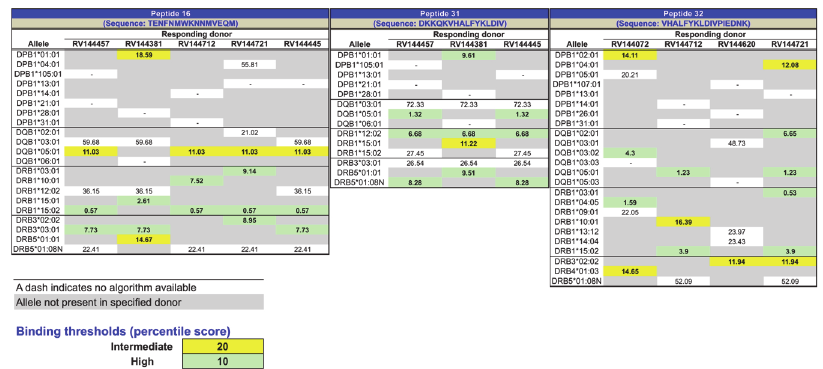
Table 1. Comparison between bAb responses and CD4+ T helper responses to C1 or V2 (p31 or p32 as indicated) respectively within the same individual. CD4 T helper C1 bAb C1 CD4 T helper V2 bAb V2 RV144072 X (p32) RV144621 RV144457 X X (p31) X (p32) X X (p31) X X X (p32) X X X X X X (p32) X X X (p32) X (p32) X X X X (p31) X RV144396 X X X: mark represents the presence in that individual of a positive response by the assay indicated. The p value for the 2x2 contingency table comparison using one tail Fisher exact was > 0.05 for both comparisons (C1 Ab vs C1 CD4 responses and V2 Ab vs V2